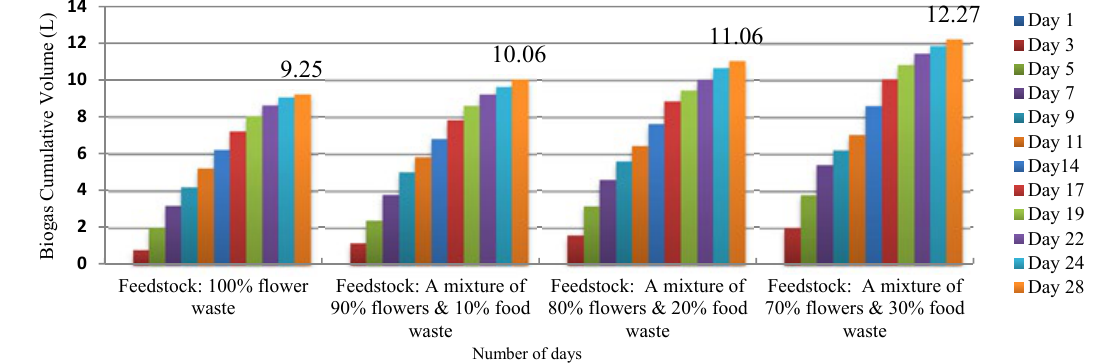
Fig. 6: Biogas generation from co‐digestion of mixture of floral waste and food waste (100g)